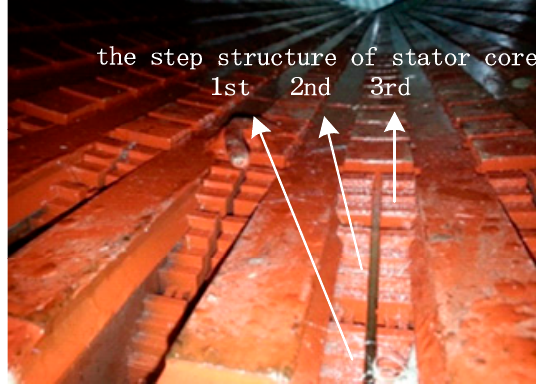
Figure 5. The step structure of stator end.